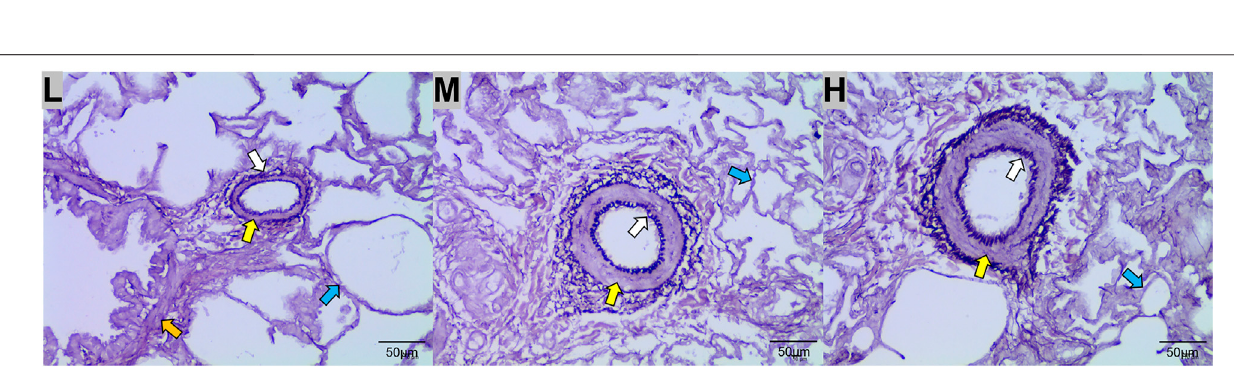
2C,l,m 1, m 2 ,h ), and the number of arterioles tended to increase